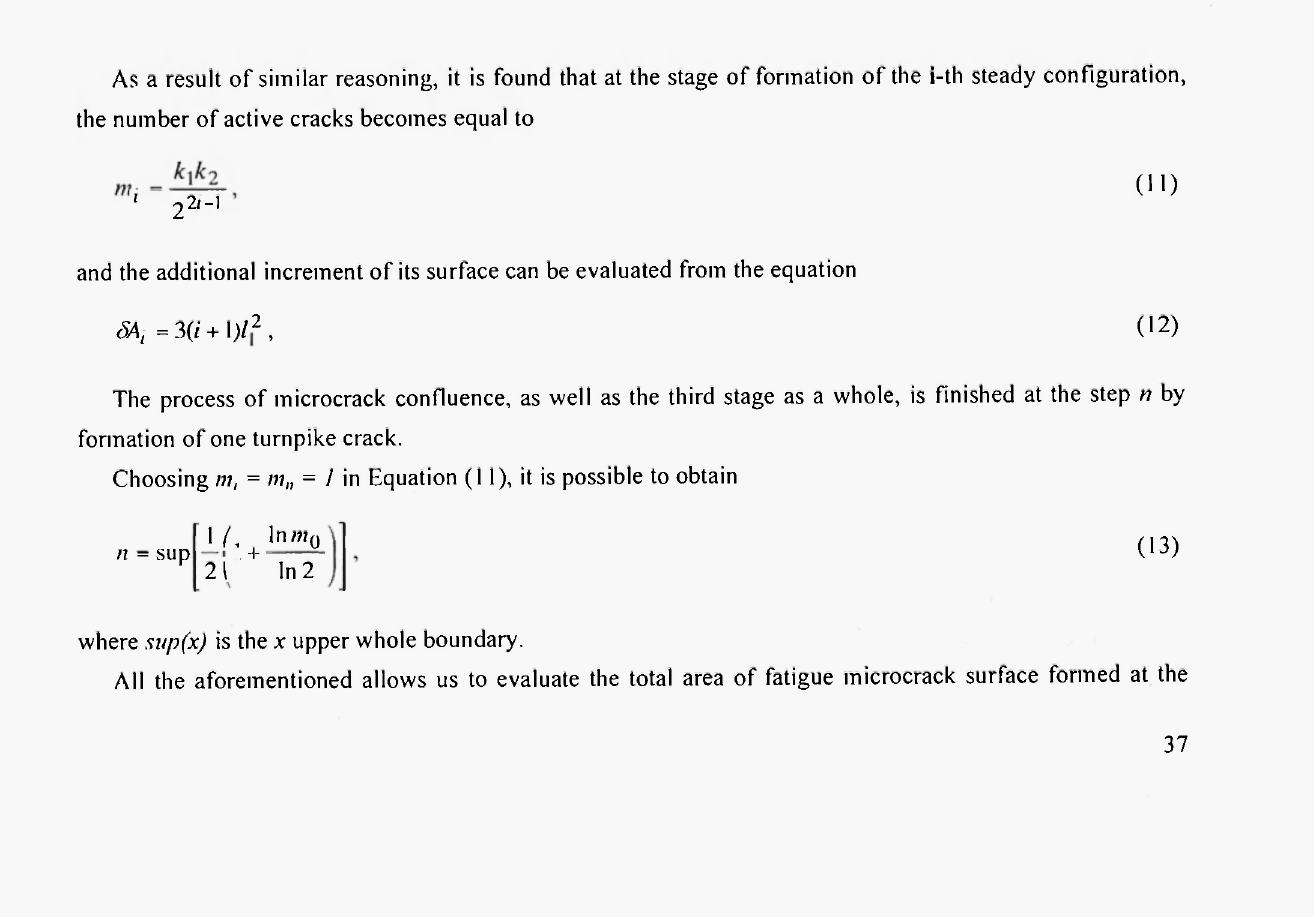
Fig. 13: Schematic of steady configurations at the following stage of the confluence process